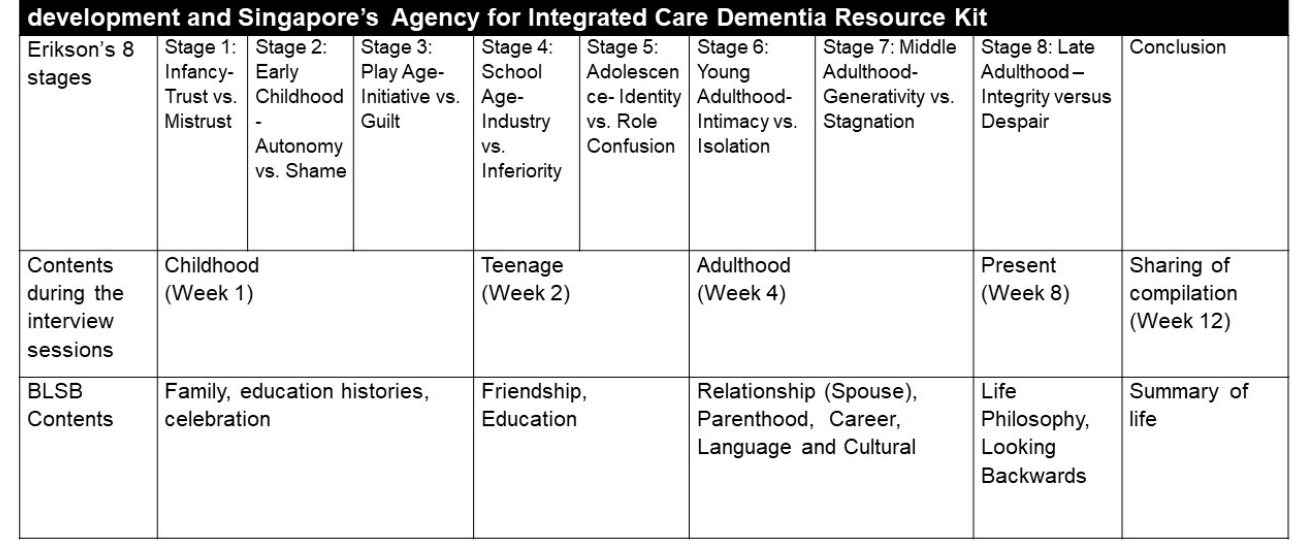
Figure 1. Design of biography and life storybook protocol.